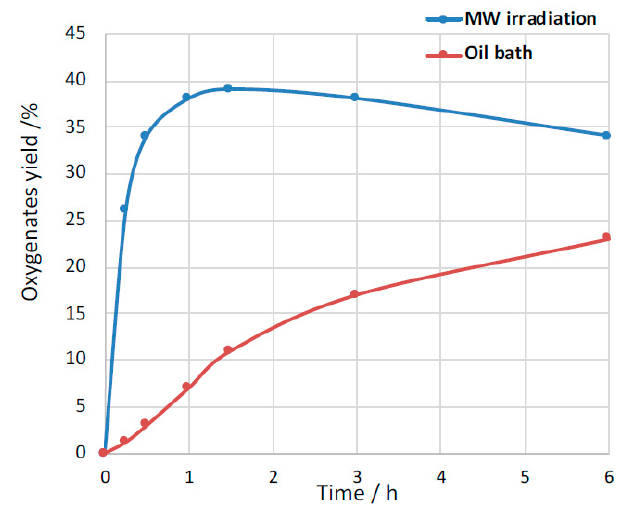
Figure 24. Vanadium Compounds tested as catalysts in oxidation with peroxides. Adapted from [159], Copyright (2019) with permission of Royal Society of Chemistry.